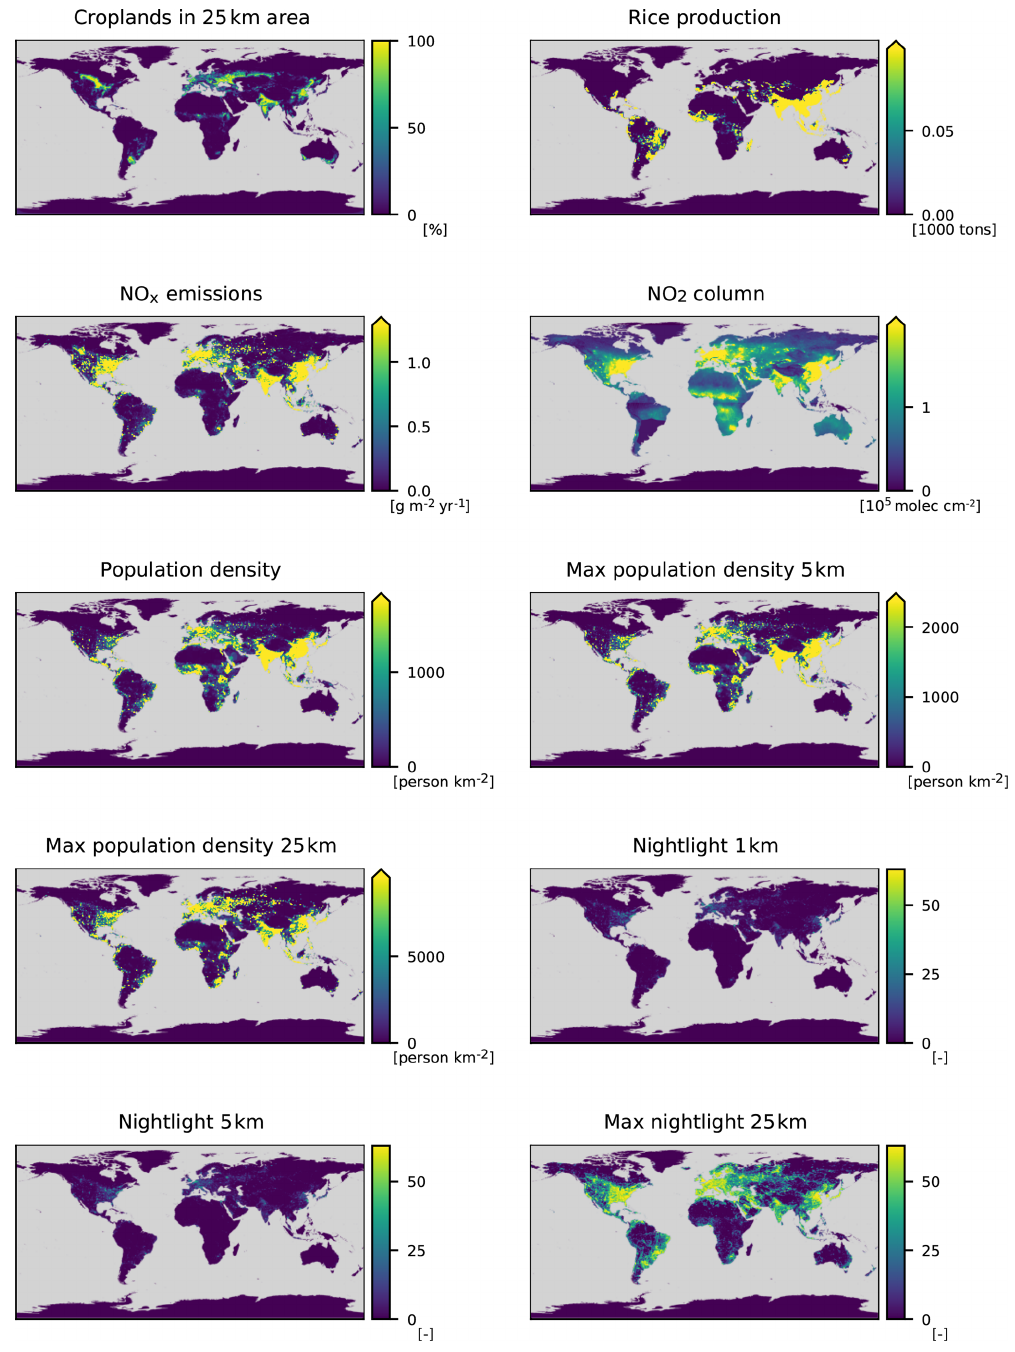
Figure B2. Gridded fields used for the final map production. Please note that the feature engineering was done as described in Sect. 2.2.2.